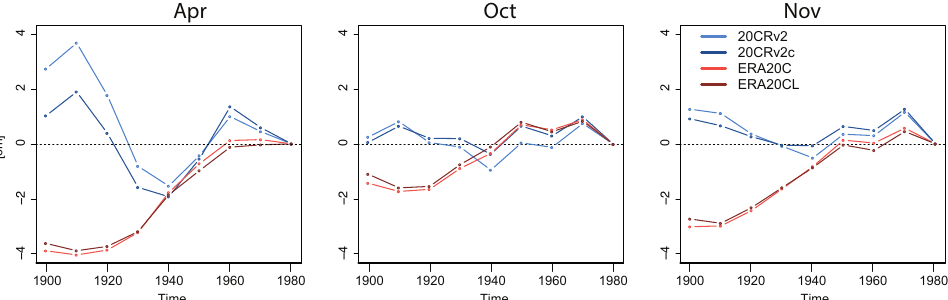
Figure 3. Time series of snow depth anomalies in (from left to right) April, October and November averaged over the main northern Russia snow pack (50–150 ◦ E, 60–75 ◦ N). Each data point represents a 30-year-long climatology, starting from 1901–1930 until 1981–2010, with 10 year shifts. Anomalies are calculated relative to the 1981–2010 climatology. ERA-20C is labeled as ERA20C, and ERA-20C land is labeled as